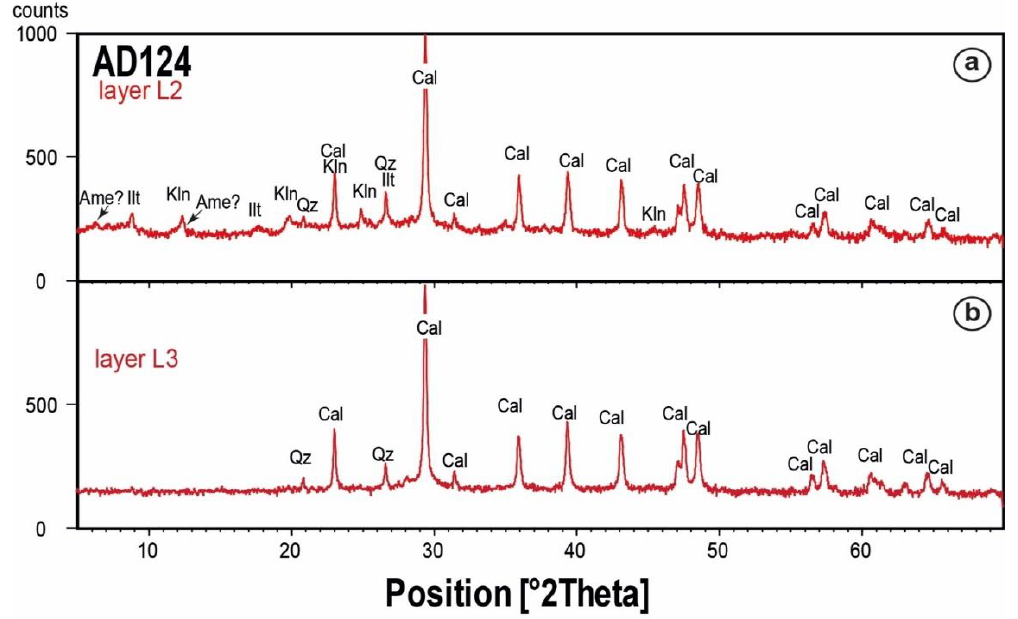
Figure 5. Representative XRD patterns of the AD-124 mortar binder: ( a ) XRD pattern of binder from layer L2 with ceramic fragments, ( b ) XRD pattern of binder from layer L3 without ceramic fragments. (Cal: calcite, Qz: quartz, Kln: kaolinite, Ill: illite, Ame: amesite).